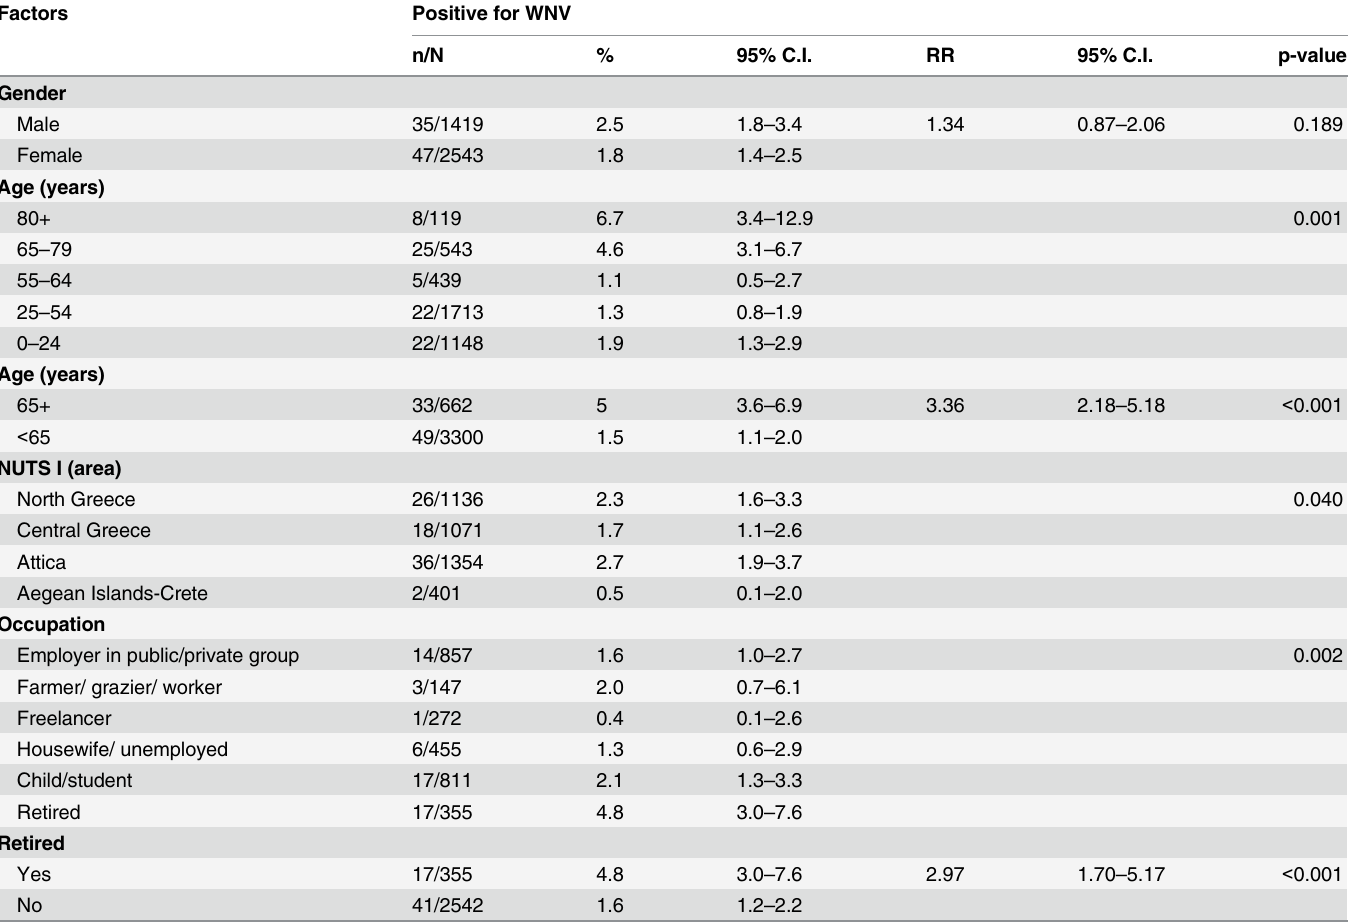
Table 2. West Nile Virus seropositivity in comparison to gender, age, area of residence, occupation and retired status (Univariate